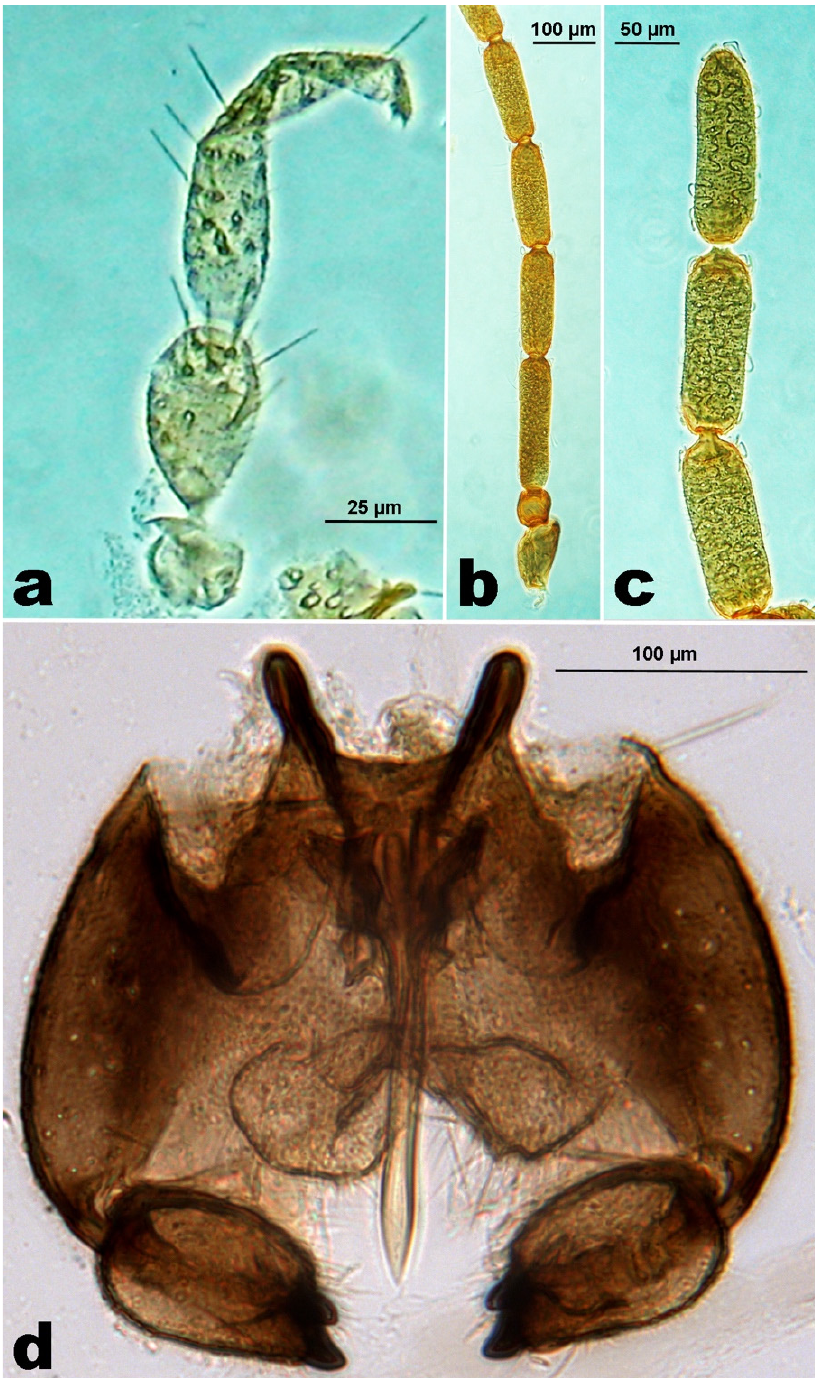
Figure 3. Male of Asphondylia rivelloi , ( a ). Palpus. ( b ). Basal segments of antenna. ( c ). Distal segments of antenna. ( d ). Genitalia.